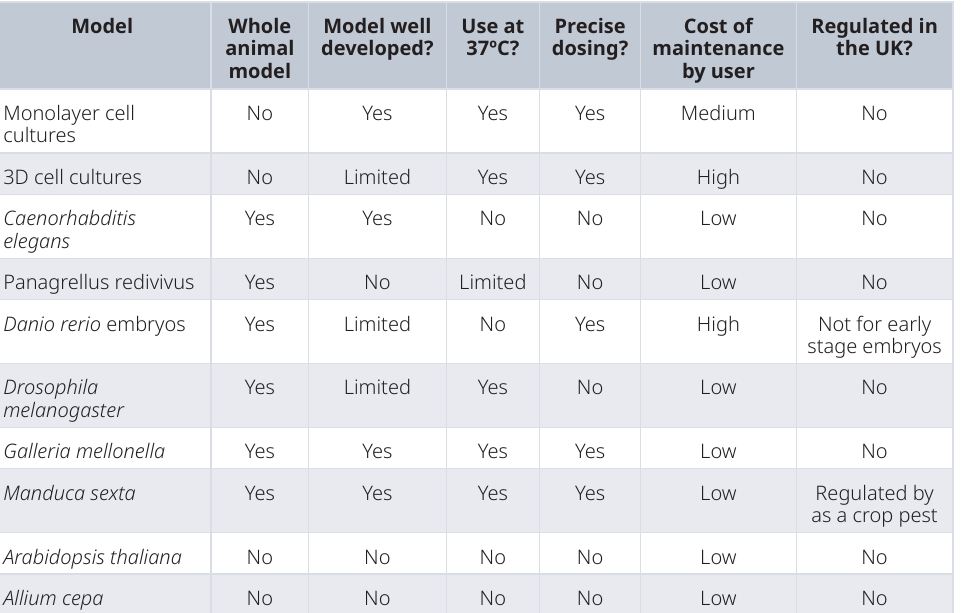
Table 1. Living systems which have been used as experimental alternatives to vertebrate